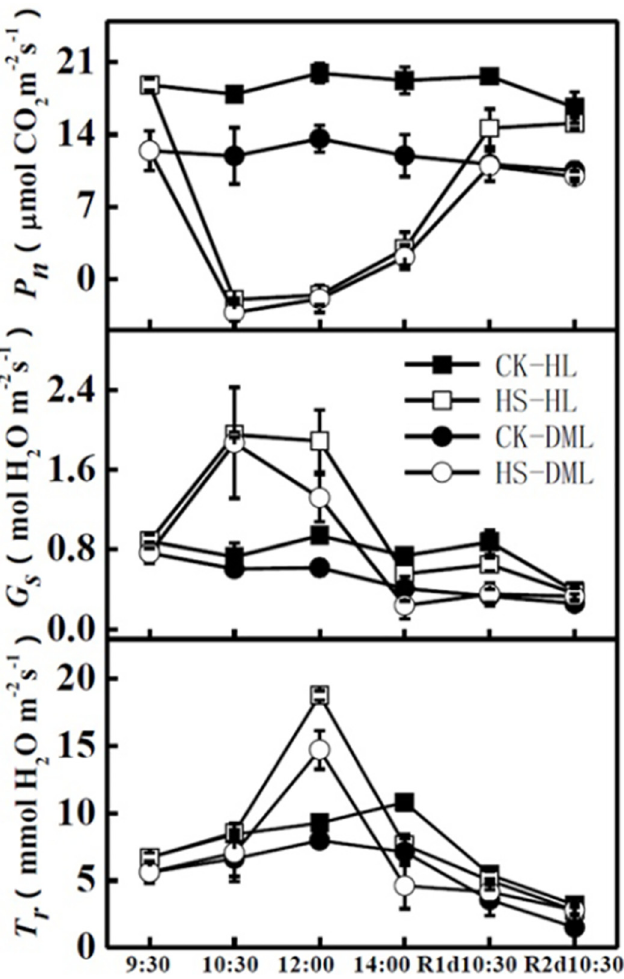
Fig 2. Effects of heat shock and recovery on the net photosynthetic rate ( P n ), transpiration rate ( T r ), and stomatal conductance ( G s ) in leaves of healthy and downy mildew infected cucumber. The data represent the mean ± SE (n = 5). CK-HL, healthy leaves without heat shock. HS-HL, healthy leaves with heat shock. CK-DML, downy mildew-infected leaves without heat shock. HS-DML, downy mildew-infected leaves with heat